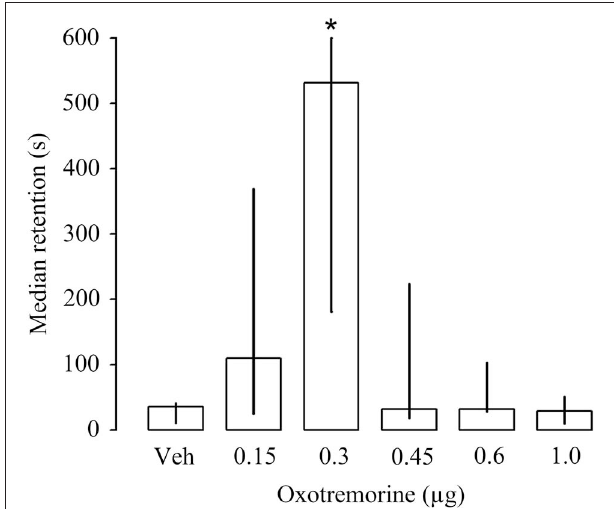
FIGURE 2 | Median latencies and interquartile ranges, in seconds on the 48h inhibitory avoidance retention test of rats given immediate post-training infusions of either vehicle (Veh) or the muscarinic receptor agonist oxotremorine (0.15, 0.3, 0.45, 0.6, and 1.0 μ g) into the dorsal striatum. The group that received the 0.3 μ g dose of oxotremorine showed longer retention latencies. ∗ P < 0 . 05 as compared to all other groups ( N = 10 rats/group).